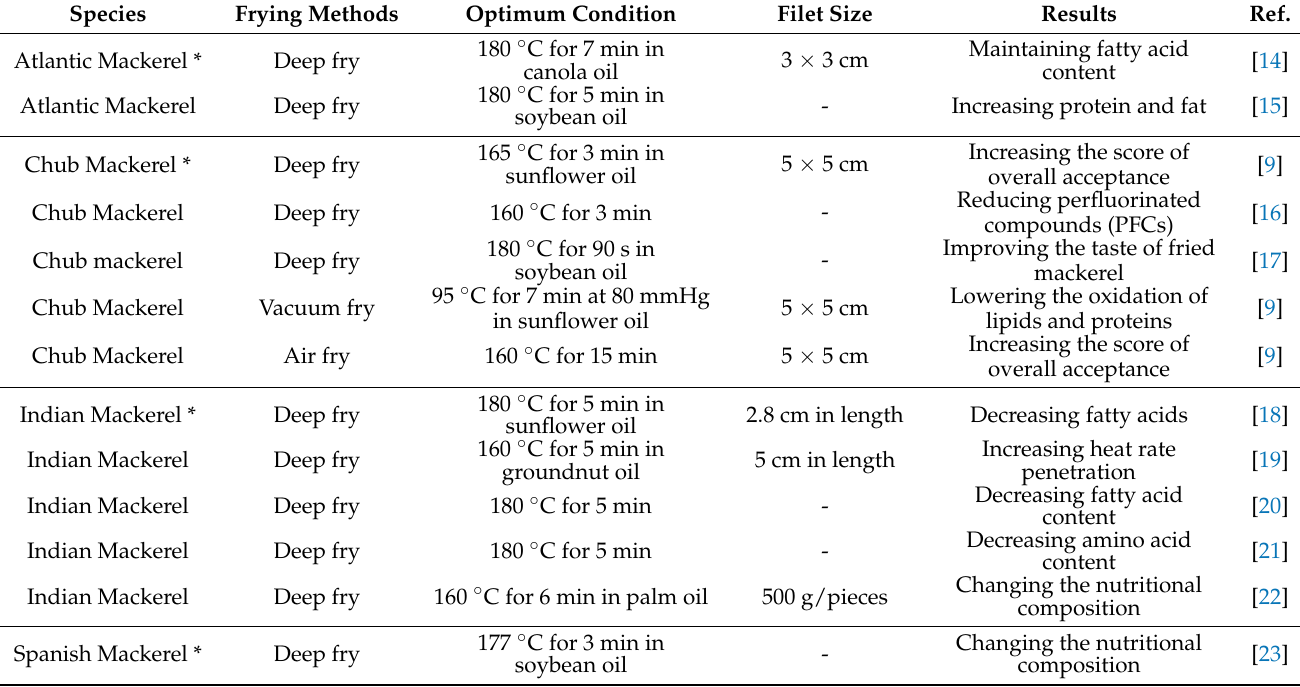
Table 1. Optimum conditions for frying mackerel without batter, marinade, and